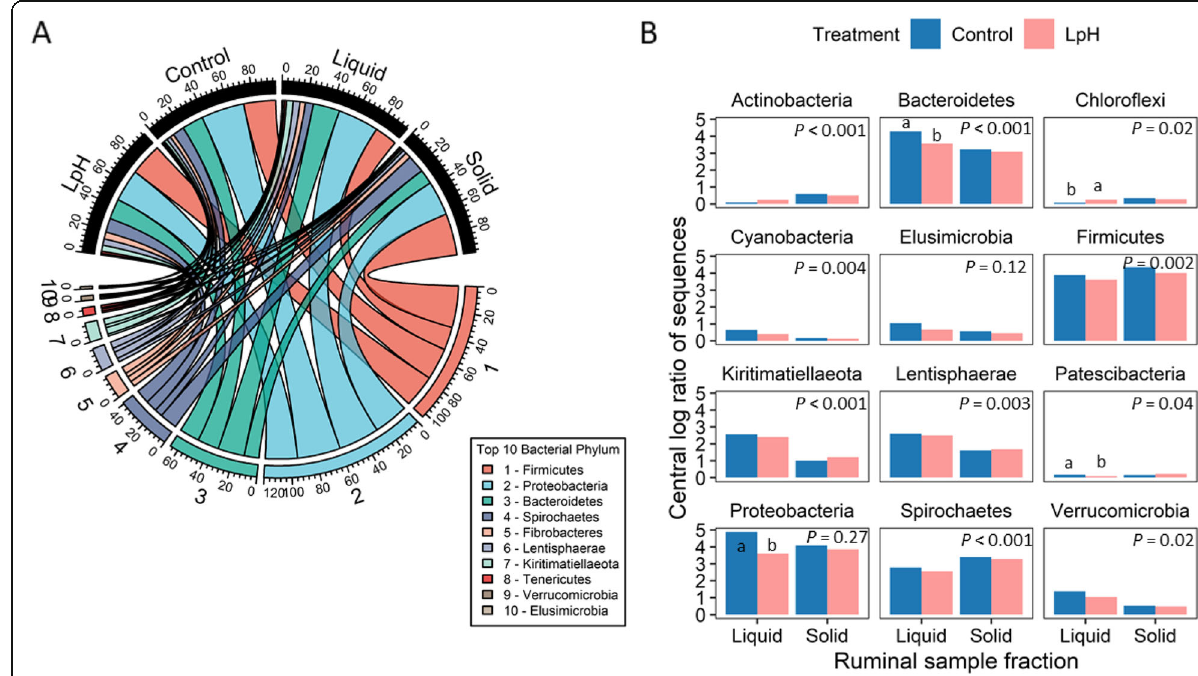
Fig. 3 Taxonomic composition of the ruminal microbiome in the liquid and solid fractions in response to normal and low pH treatments. The top 10 bacterial phyla were selected, and sequences were expressed as relative abundance (A). The bar chart shows bacterial phyla that were significantly affected by treatment or by sample fraction (B). P value in each block shows difference between the liquid and sloid fraction, and different characters indicate significantly different means within the liquid or solid fraction. Results are reported as central log ratios of sequences where a value of 1 represents the mean